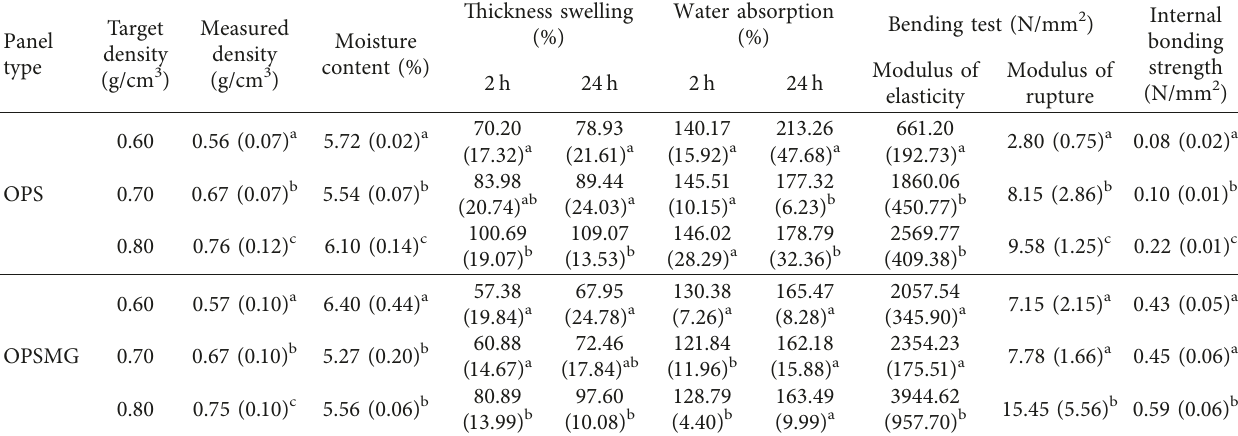
Table 2: Statistical analysis for wood composites made using OPS and OPSMG as a binder.